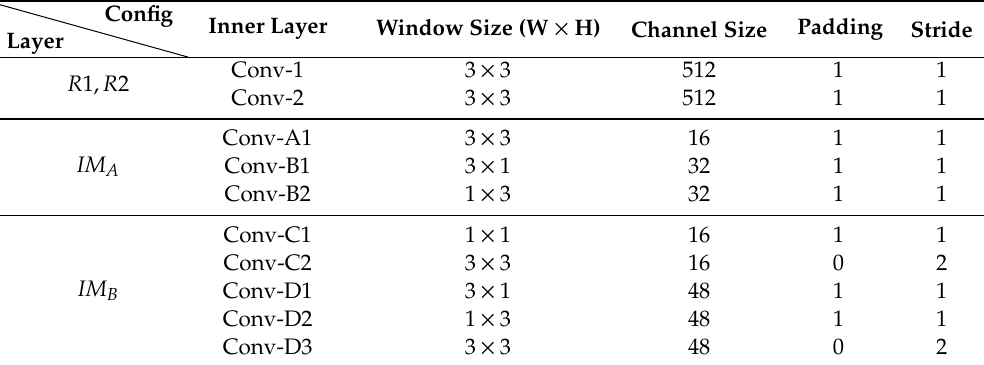
Table 1. Layer configuration of